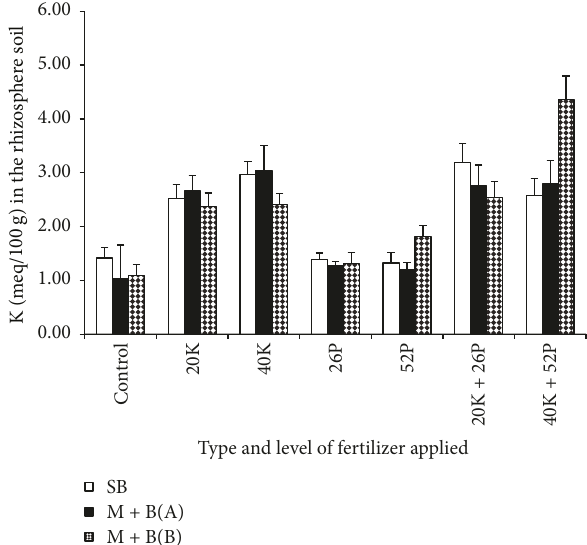
Figure 1: Interactive effect of cropping systems and fertilizers on rhizosphere soil K content. SB: sole soybean; M + B (A): maize/soybean intercropped at a spacing of 75 × 60 cm and 75 × 20 cm, maize, and soybean, respectively; M + B (B): maize/soybean intercropped at a spacing of 75 × 60 cm and 75 × 40 cm, maize, and soybean, respectively.